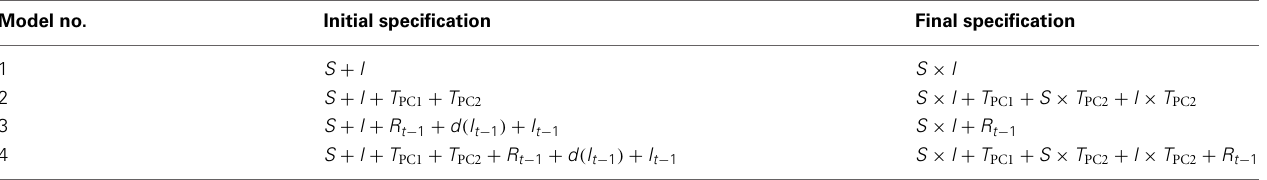
Table 2 | Specification of logistic regression models used to predict choice. Model